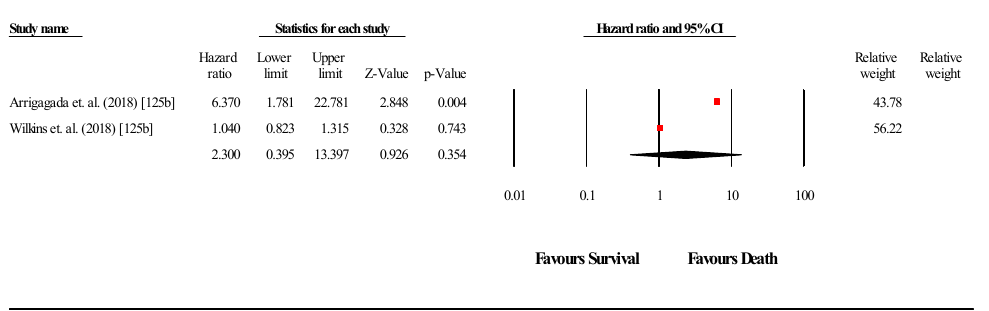
Figure 10. Forest plot for miR-20a association with OS.